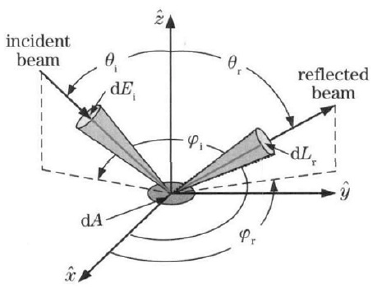
Figure 1. Incidence and reflected vectors of BRDF model [6].